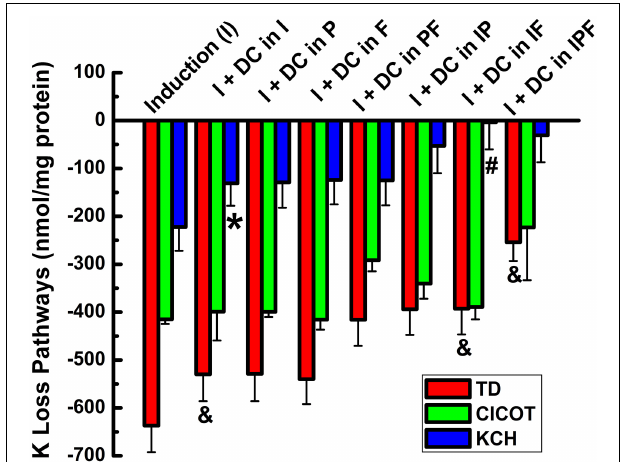
FIGURE 10 | Cl-dependent Rb + influx and K i loss triggered by constitutive KCC3 Thr991/Thr1048 dephosphorylation is DCPIB-sensitive. Bars indicate Rb + influx through Cl-dependent cotransporters (NKCC + KCC, cyan) and K i loss (NKCC + KCC, magenta), when DCPIB was applied in the induction (I), preincubation (P), and/or flux (F) stages of the ion flux study. DCPIB inhibits Cl-dependent Rb + influx and K i loss depending on the conditions. Representative results from 4 similar experiments. For Rb + (NKCC + KCC), there was a statistically significant difference between groups as determined by One-Way ANOVA [ F (8 , 27) = 48 . 75 , p < 0 . 0005 , n = 36 ]. For K + (NKK + KCC), there was a statistically significant difference between groups as determined by Kruskal–Wallis One-Way ANOVA [ F (8 , 27) = 20 . 51 , p < 0 . 0005 , n = 36 ]. Data represent the mean ± SEM